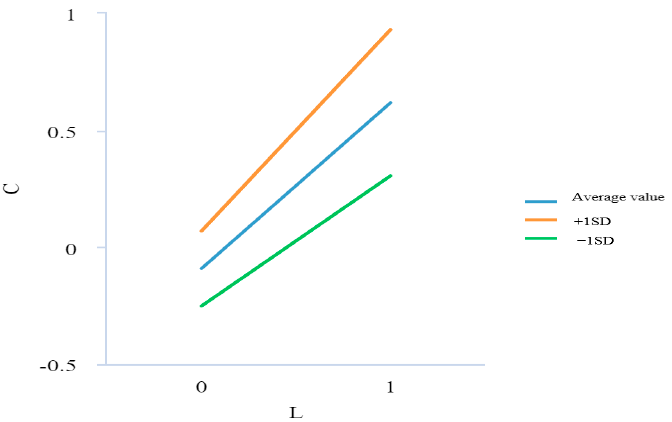
Figure 3. Simple Moderating of the Slope.